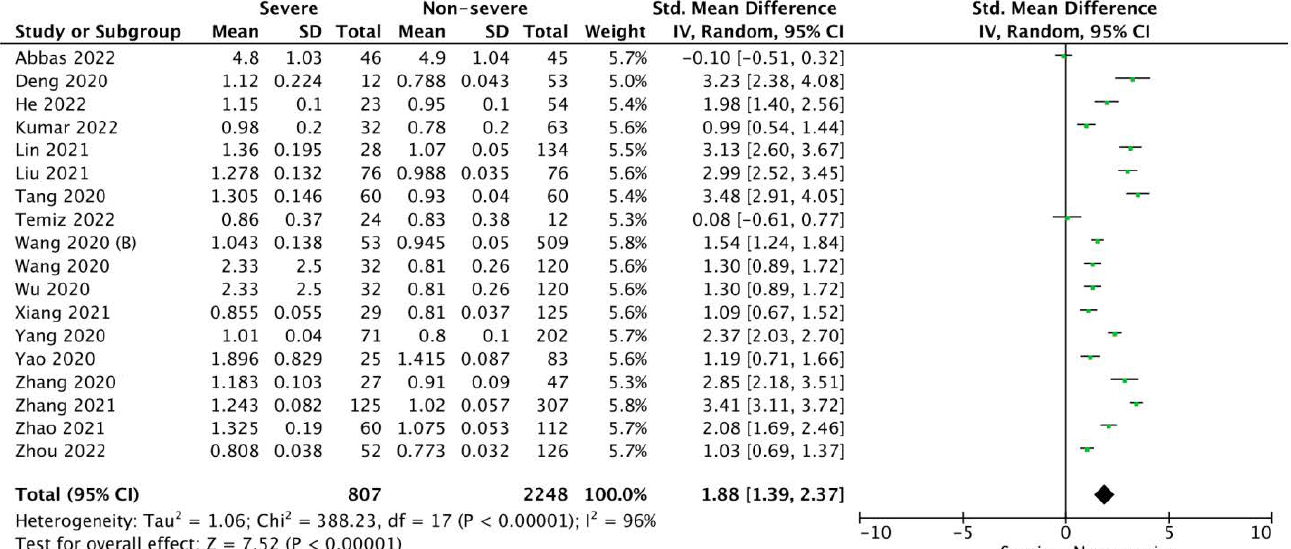
Figure 3. Forest plot of Cystatin C levels among severe vs. non-severe patients with COVID-19. The center of each square represents the standard mean differences for individual trials, and the corre- sponding horizontal line stands for a 95% confidence interval. The diamonds represent pooled re- sults. Legend: CI: confidence interval; SD: standard deviation.